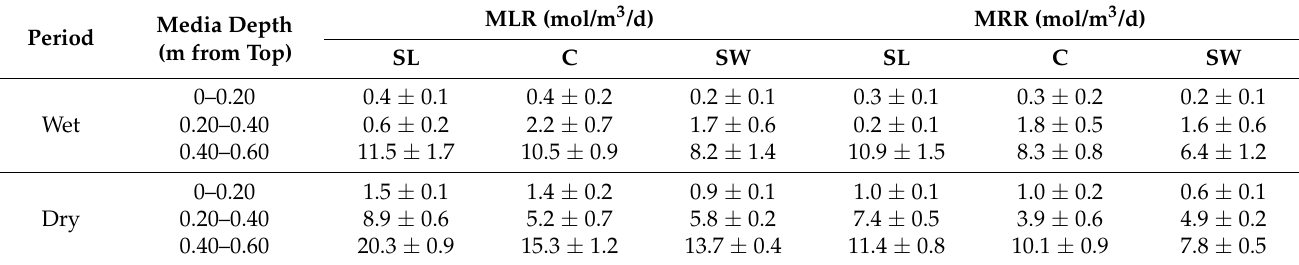
Table 3. Observed methane loading and removal rates in bio-cover